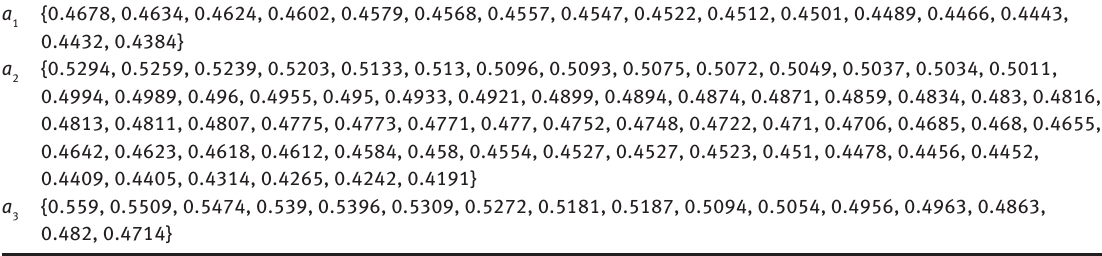
Table 11: The Collective Overall Preference